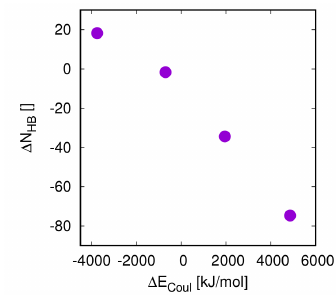
Figure 4. Correlation between the change in Coulomb interaction energy ∆ E Coul and change in the number of H-bonds ( ∆ N HB ) in blends of 40 wt % FLA with PVP, EEC, PSA, and PAA (from higher to lower values of ∆ N HB ). Numbers are the differences between the quantities in the mixtures and of the equivalent numbers of molecules in the pure phases.